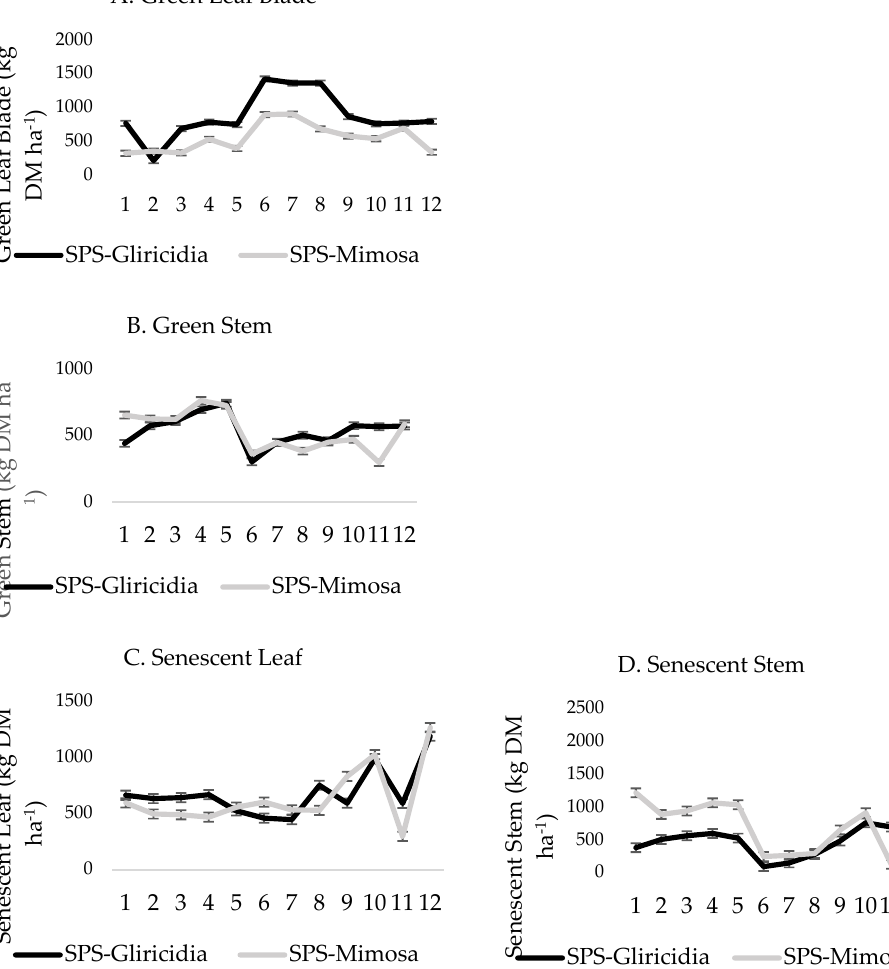
Table 2. Green leaf blade in one-row and in double-row during the experimental period. Evaluation